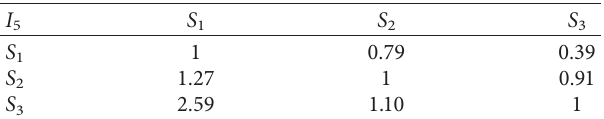
4 . Table 13: Weightage of the indicator NC by AHP on prediction 5 .